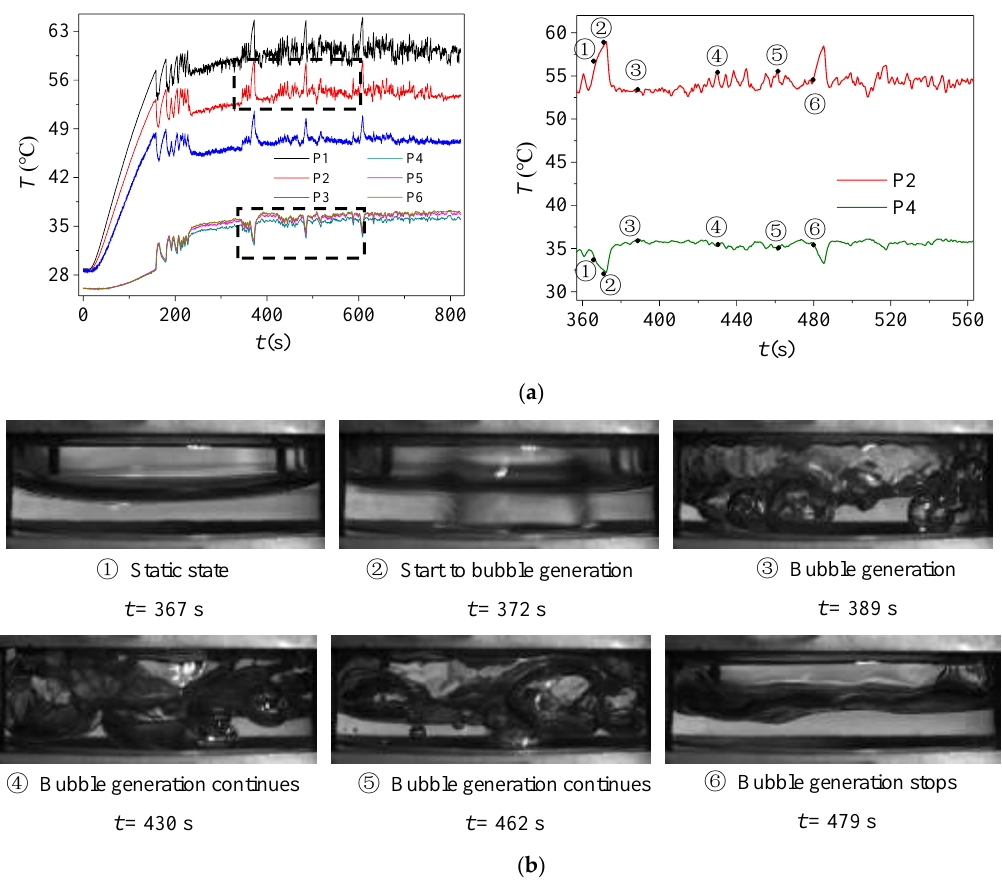
Figure 9. Alternate pulsation state (State B-2, φ = 47%, q = 16.8 W/cm 2 ): ( a ) characteristics of wall temperature pulsation; ( b ) gas–liquid two-phase behavior in one cycle.